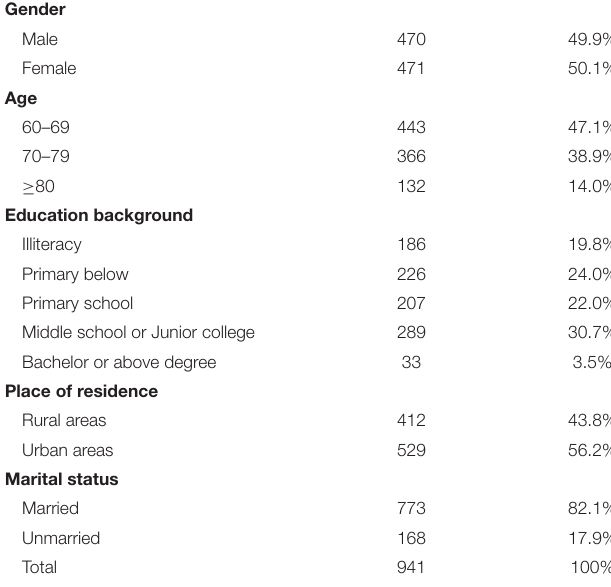
TABLE 1 | Description of